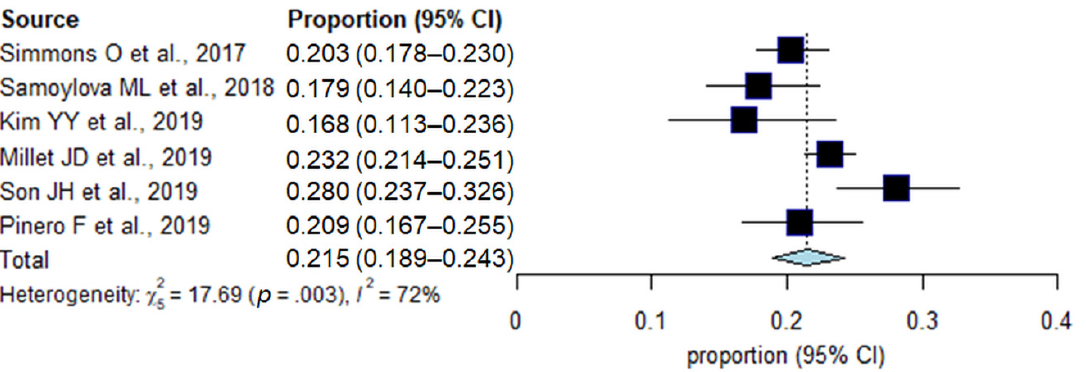
Figure 2. Forest plots of the pooled incidence of inadequate US examination. Table 2. Subgroup analysis for the incidence of inadequate US examination.